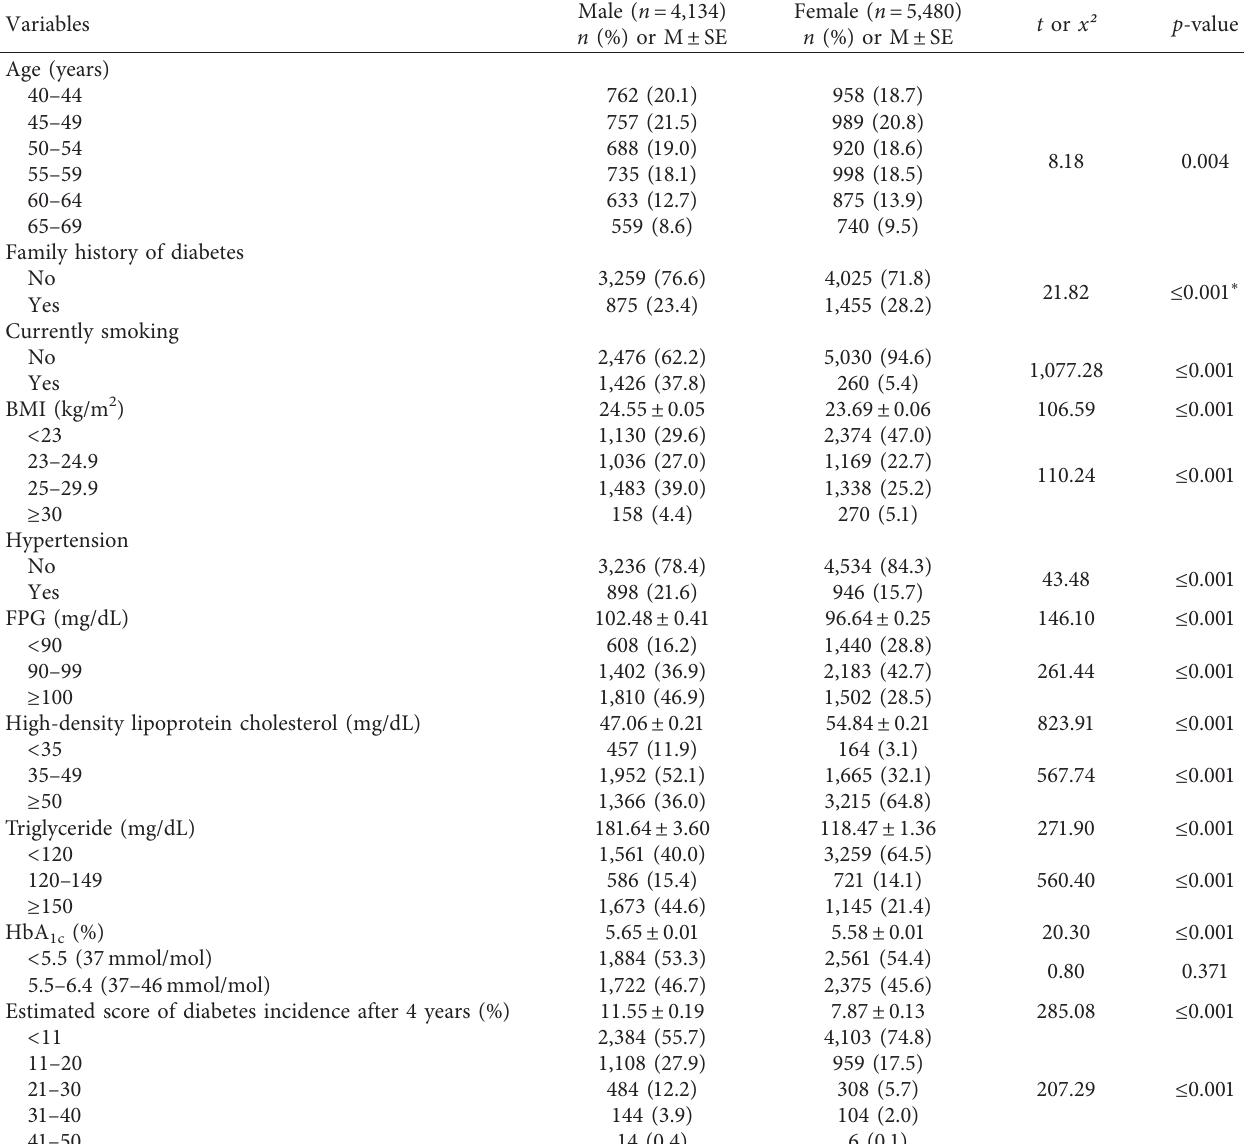
Table 2: Comparison of the 4-year estimated incidence of T2DM according to sex ( n � 9,614).